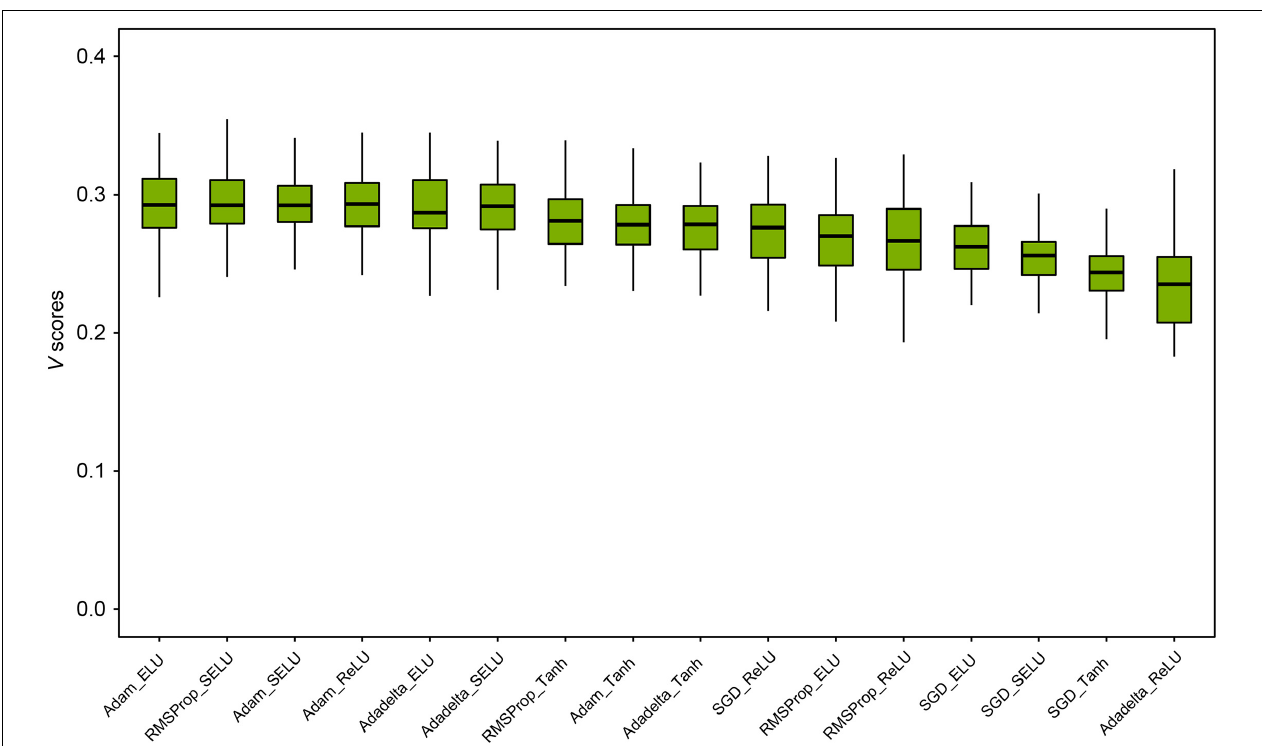
FIGURE 2 | Hyperparameters optimization of DNN models: we investigated a total of 16 hyperparameter combinations of four activation functions (i.e., Tanh, ReLU, SELU, and ELU) and four optimizers (i.e., Adam, Adadelta, RMSProp, and SGD). Each hyperparameter combination was evaluated with a 100-iteration MCCV. The mean and standard deviation of V scores is illustrated for each hyperparameter combination. The hyperparameter combination of Elu and Adam was chosen as the best hyperparameters for developing an optimized DNN model.